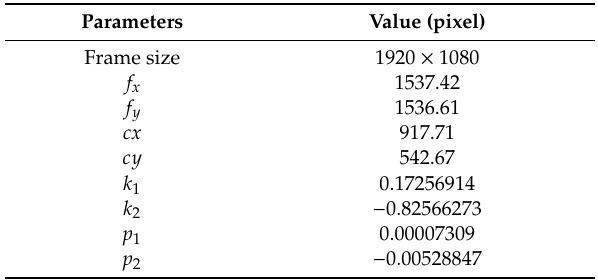
Table 2. Parameters of the sensor carried on the DJI Mavic Pro. f x and f y are the focal lengths expressed in pixel units; ( cx , cy ) is a principal point that is usually at the image center; k 1 and k 2 are the radial distortion coe ffi cients; p 1 and p 2 are the tangential distortion coe ffi cients.